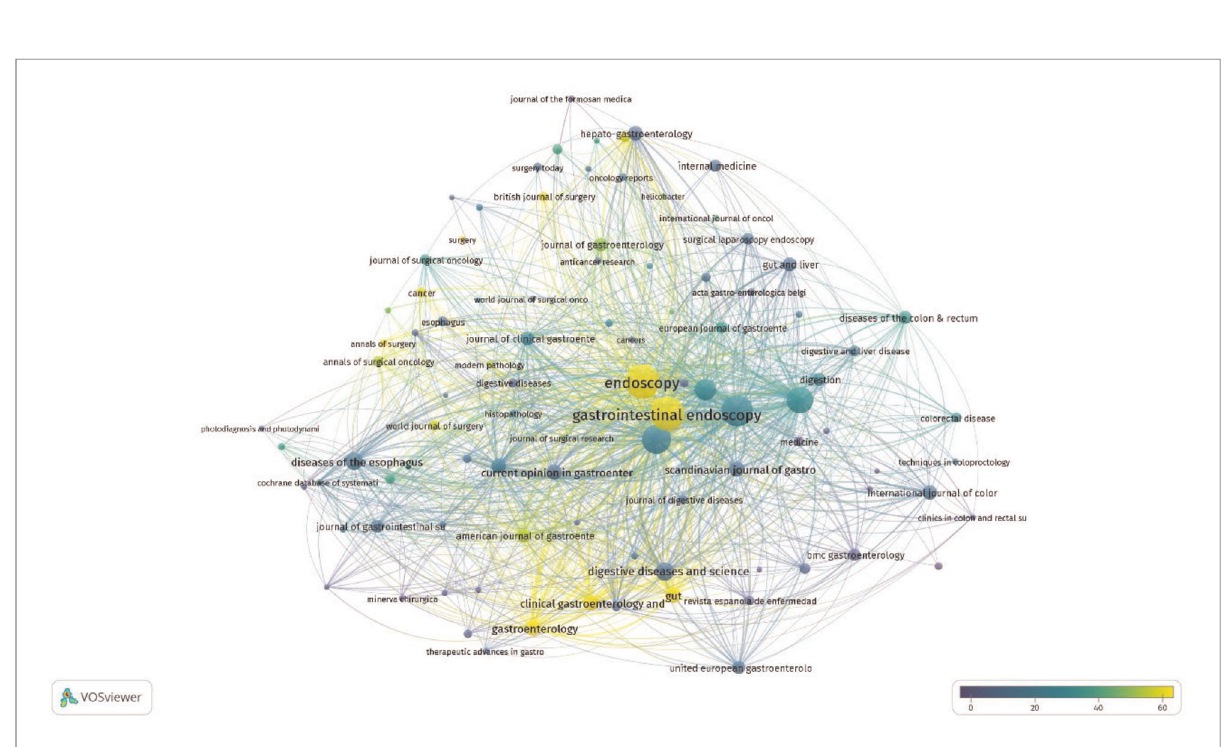
FIGURE 5 Co-occurrence map based on